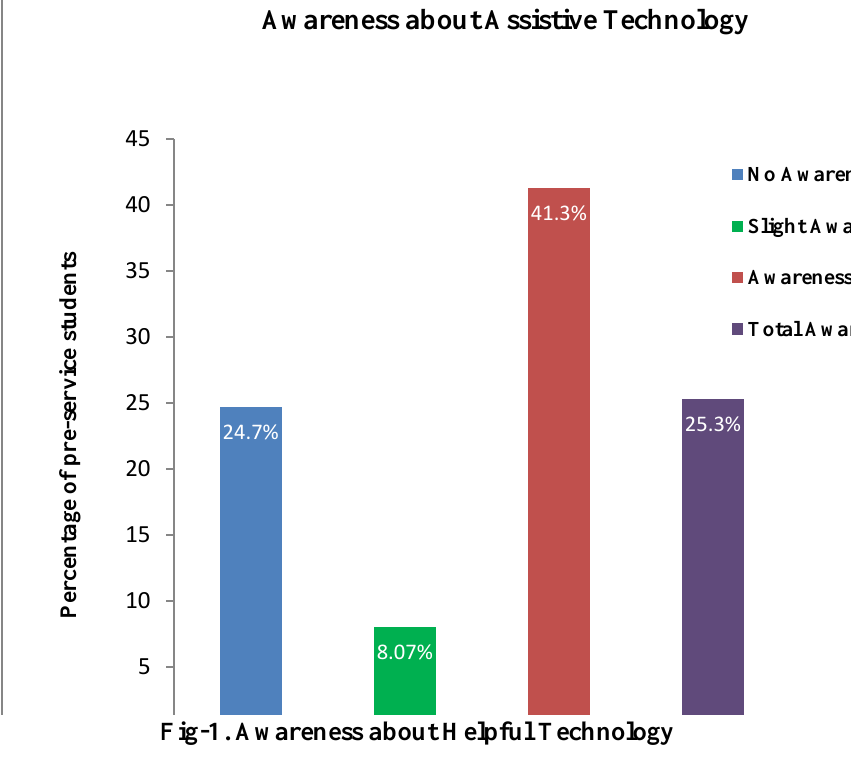
Fig-1. Awareness about Helpful Technology